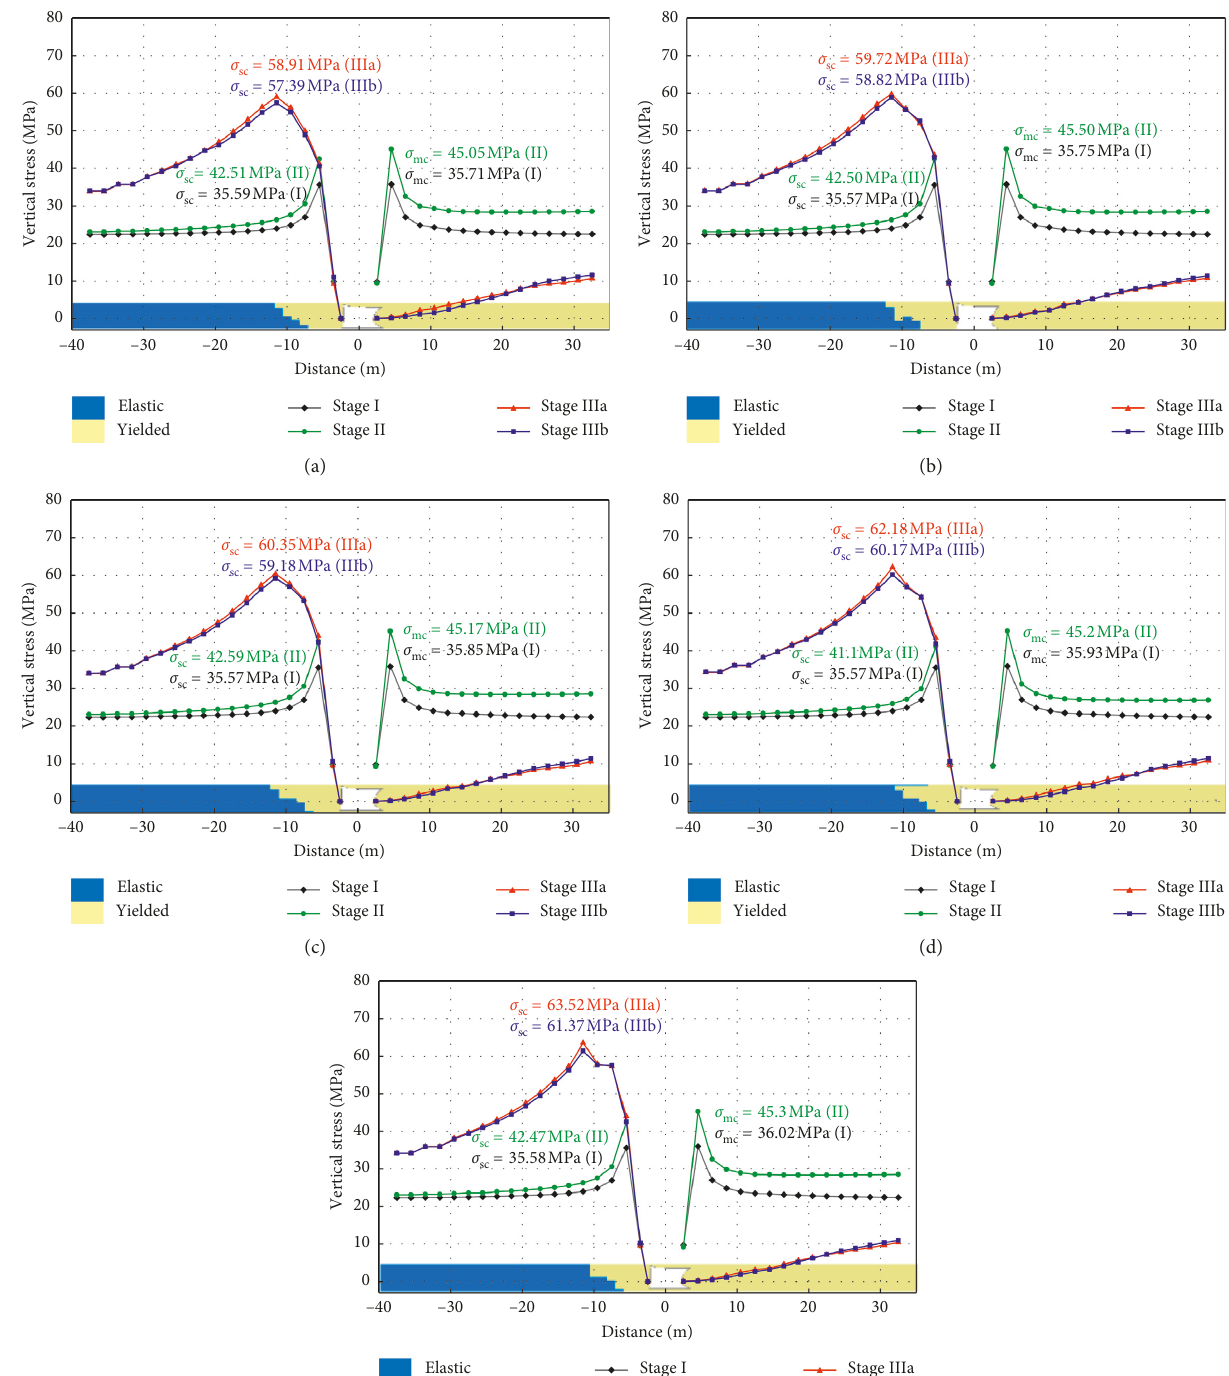
Figure 14: Vertical stress distribution in 21304 gob and 21305 panel with different roof fracturing angles: (a) 10 ° ; (b) 15 ° ; (c) 20 ° ; (d) 25 ° ; (e) 30 °